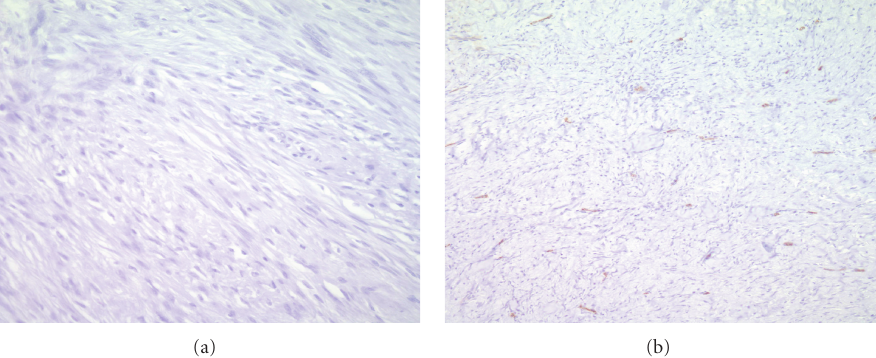
Figure 8: The tumor cells are negative for CD 117 immunostain ((a) × 200) and CD 34 immunostain ((b) ×